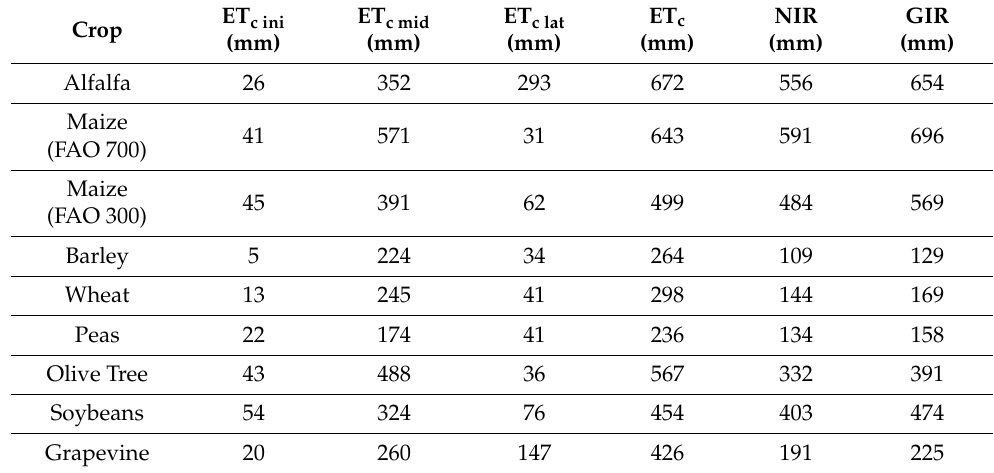
Table 6. Potential crop evapotranspiration (ET c ), net irrigation requirements (NIR) and gross irriga- tion requirements (GIR) for the crops in the AB5 sub-basin for a given